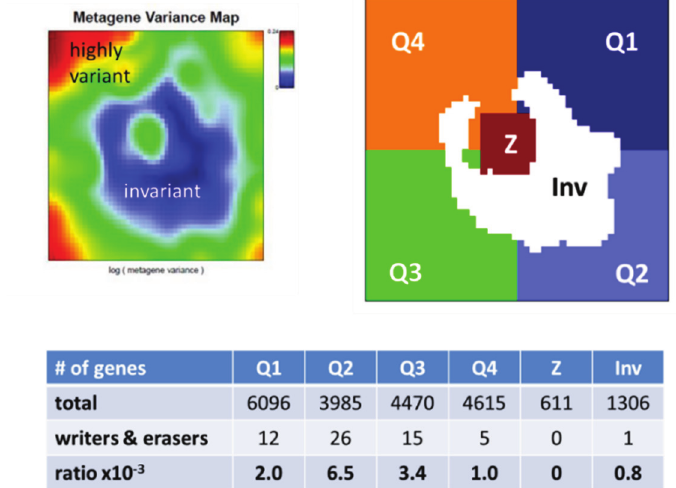
Figure 6. Enrichment characteristics of writers and erasers of histone and DNA methylation marks in the expression SOM. We segmented the map as shown in Figure 2 into four quadrants Q1–Q4 and a central area Z. In addition, we separately considered genes with invariant expression profiles, which populate the blue area in the variance map (Inv). Then we counted the number of genes and of writers and erasers of methylation marks in each of the areas. These modifiers were strongly enriched in Q2, on intermediate levels in Q1 and Q3 and on low levels in Q4, Inv and